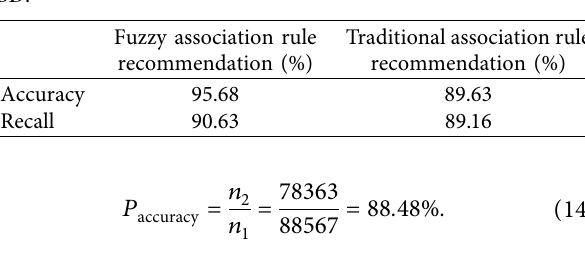
Table 5: Comparison of accuracy and recall rates of two methods in BD.